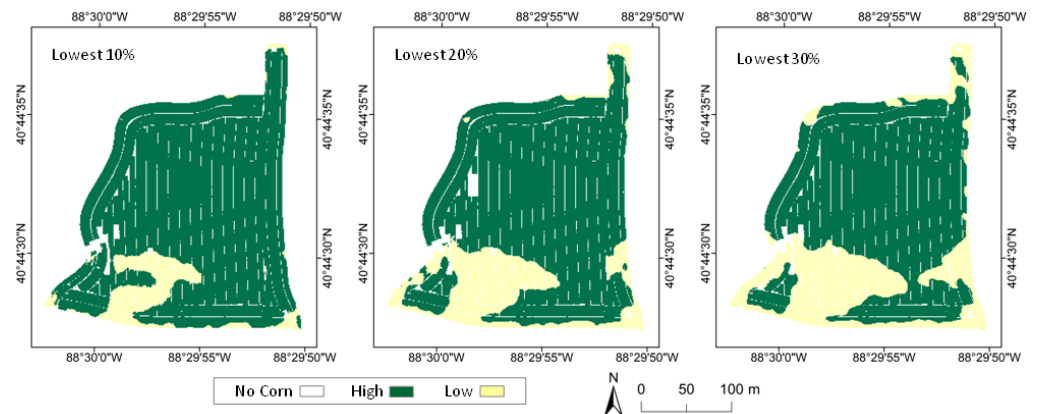
Figure 3. Examples of stratification of under-productive land by percent area in Fairbury